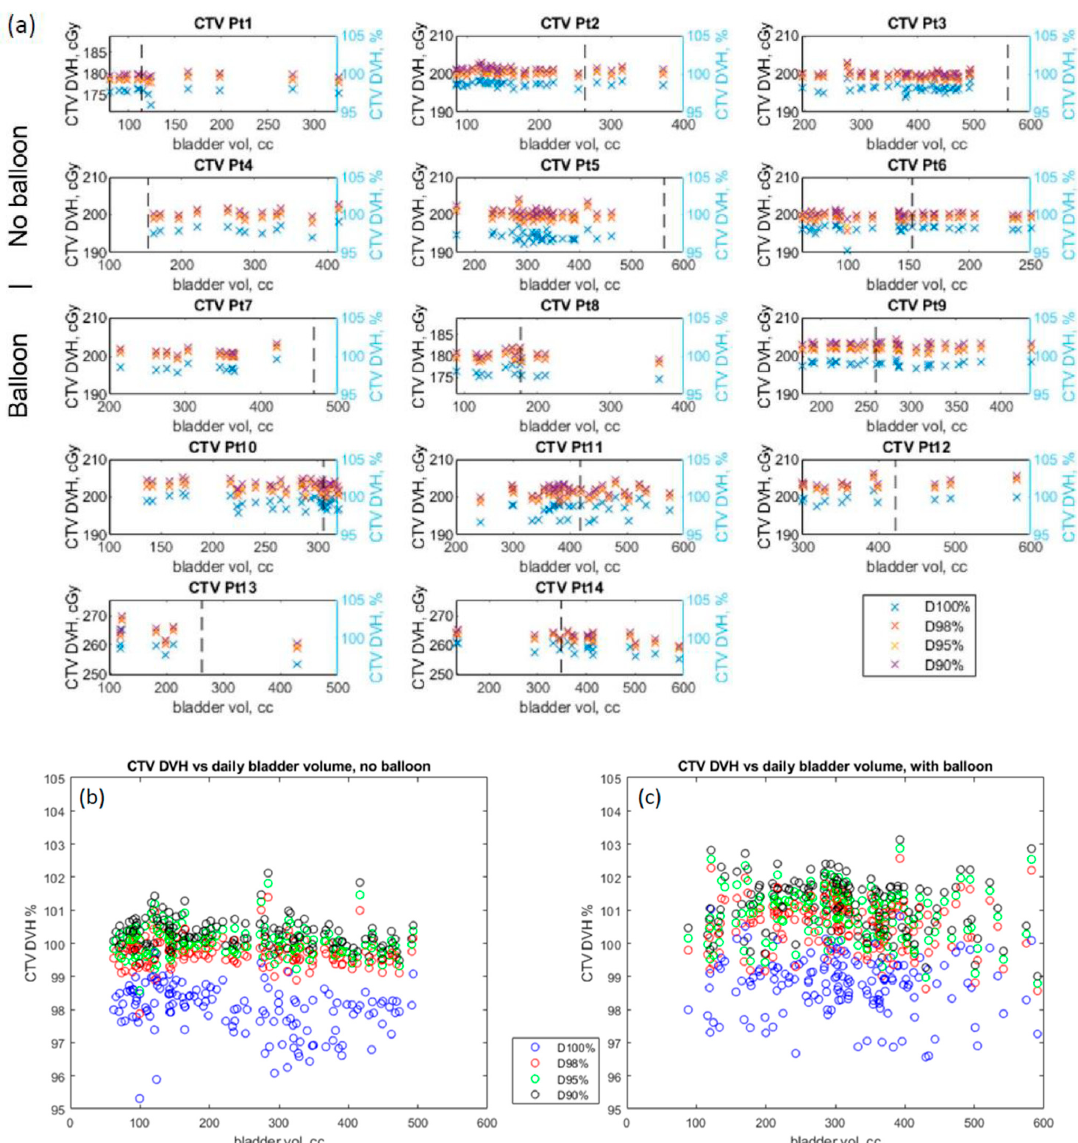
Figure 5. ( a ) CTV coverage for each patient as a function of daily bladder volume. The dashed black line indicates the planning bladder volume. CTV coverage as a function of daily bladder volume for patients without endorectal balloon ( b ) and with endorectal balloon ( c ).